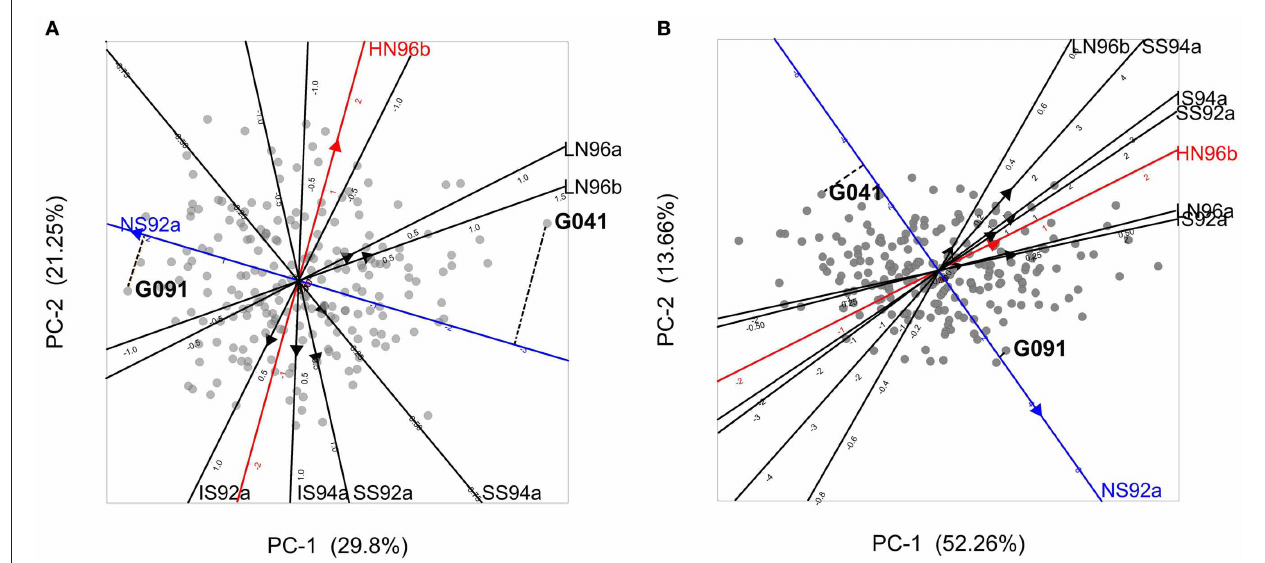
FIGURE 4 | (A) Biplot from the AMMI model used to describe GEI in the maize example data. Gray circles represent genotypes, and filled triangles environments, with triangles pointing in the direction of increasing GEI (at origin GEI = 0). The projection of two genotypes (G041 and G091) on the NS92a axis is shown by a dashed line. (B) GGE biplot for the maize